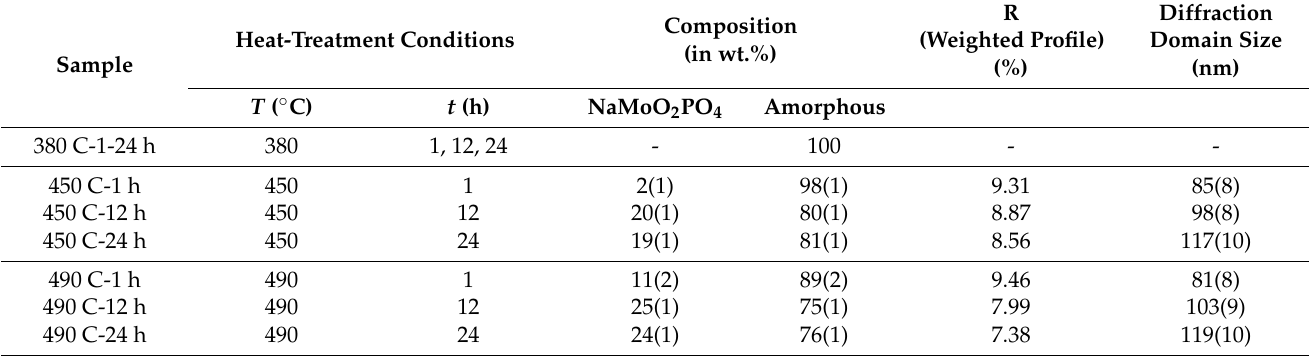
Table 1. Quantitative composition of the samples heat-treated for 1–24 h at 380, 450 and 490 ◦ C.